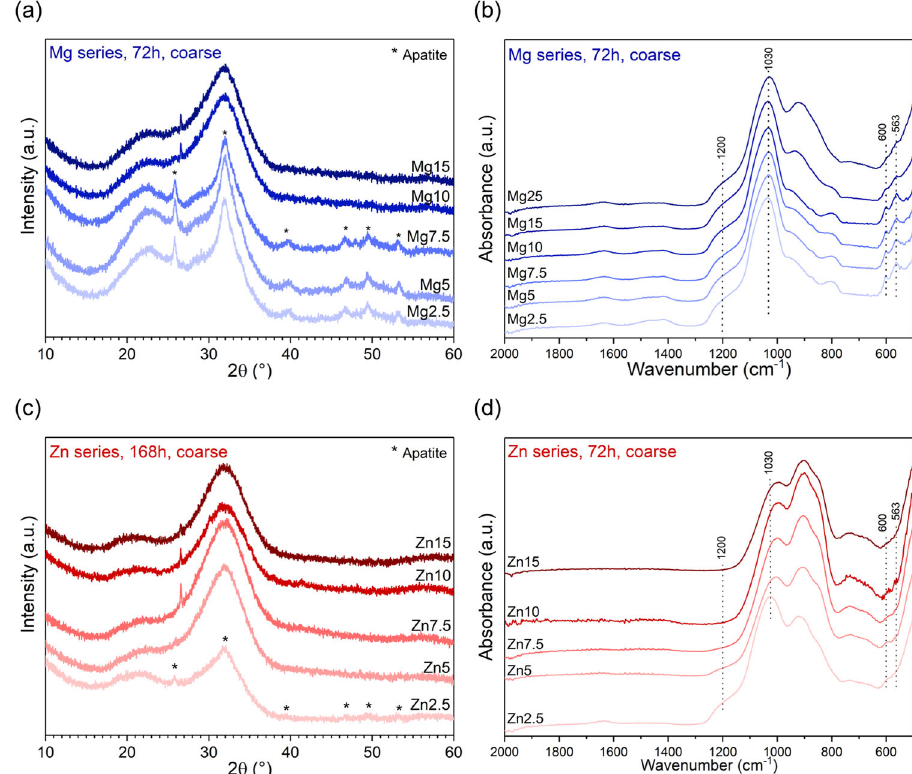
Fig. 5 a , c XRD patterns and b , d ATR-FTIR spectra of coarse particles of ( a , b ) Mg and ( c , d ) Zn-substituted glasses after immersion in Tris buffer solution for ( a , b , d ) 3